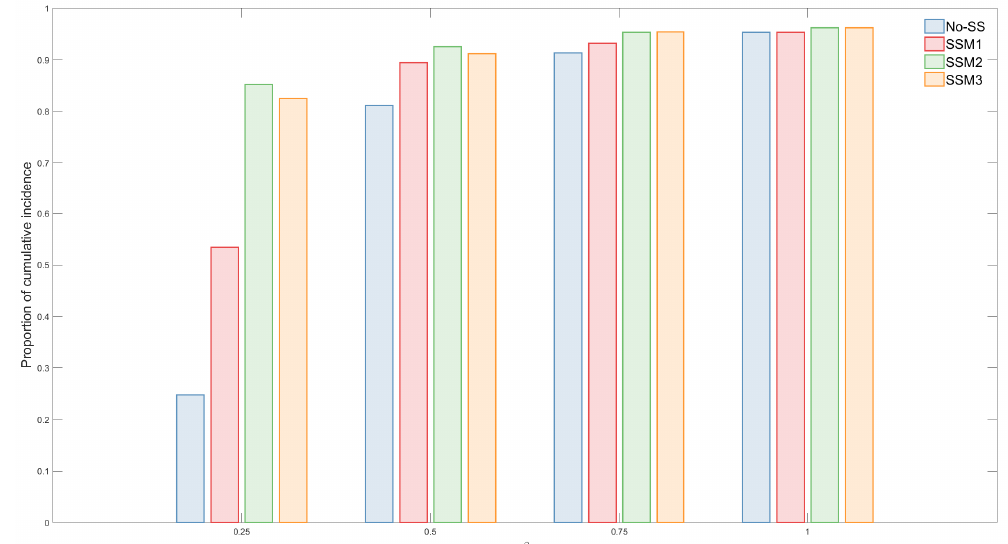
Figure 8. The impact of the baseline transmission rate β 0 is shown under four models. In all models, the peak size increases rapidly as β 0 increases. The difference is most significant in SSM